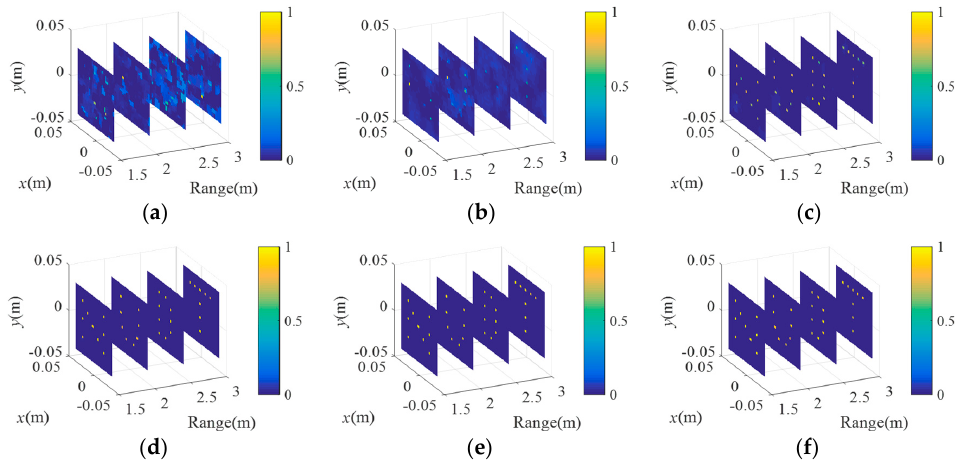
Figure 6. Comparison of imaging results for C-TCAI and GM-TCAI for sparse targets at various SNRs. ( a – c ) Imaging results for C-TCAI at − 25 dB, − 15 dB, and − 5 dB; ( d – f ) imaging results for GM-TCAI at − 25 dB, − 15 dB, and − 5 dB.